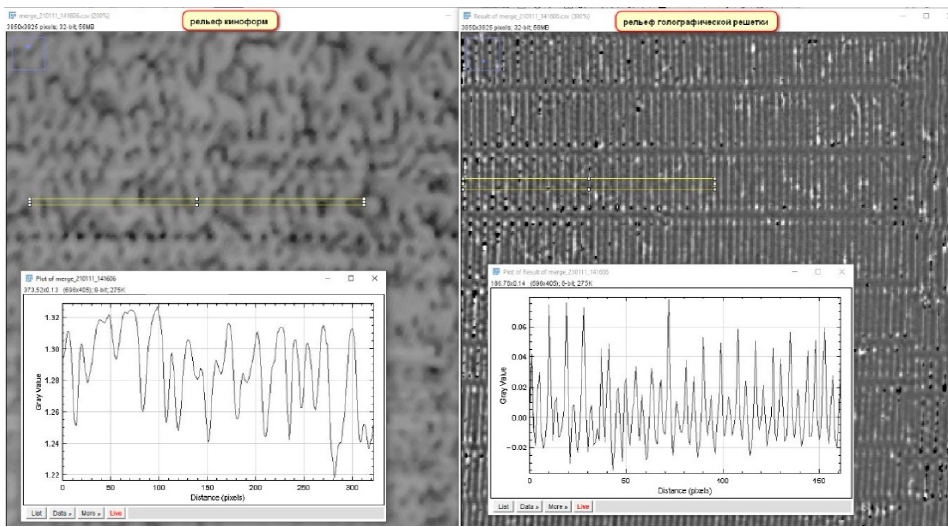
Figure 5. Profiles of kinoform and diffraction grating of the main hologram.